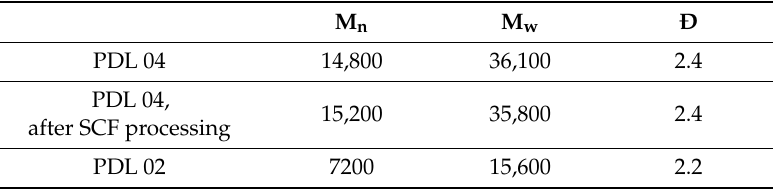
Table 1. Molecular weight characteristics of the polymers.